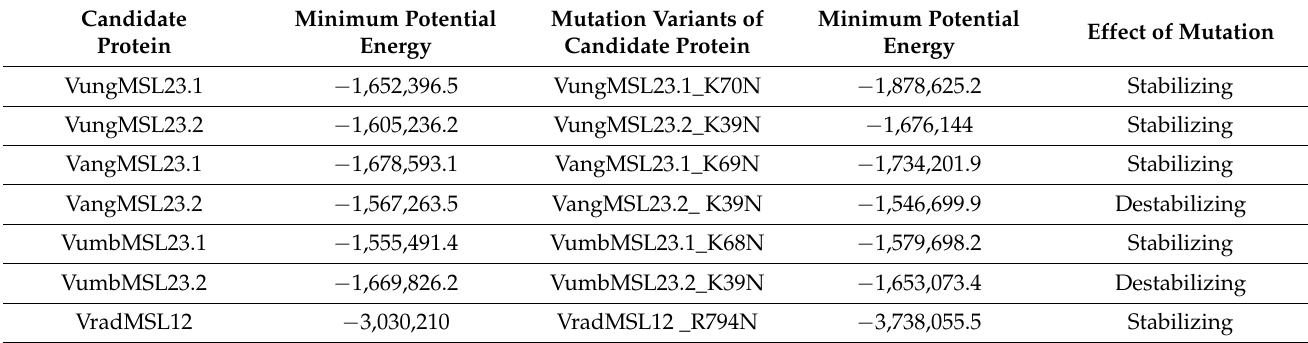
Figure 9. The 3D structure of proteins representing two variants of OsMSL23 homolog in Vigna crops showing two variants of each protein (K/R to N substitution). Table 5. Minimum stable potential energy of candidate protein for shattering and its mutation variants.